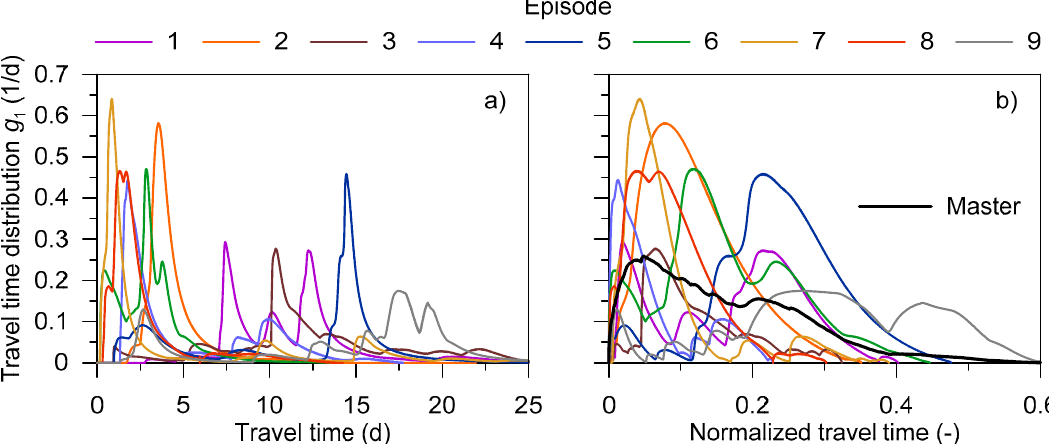
Figure 3. Episodal travel time distributions of stormflow for the selected rainfall–runoff episodes plotted against travel time since tracer application ( a ) and against flow-corrected travel time obtained as the cumulative volume of stormflow divided by the final volume of rainfall ( b ). The master travel time distribution is shown in the flow-corrected time projection.